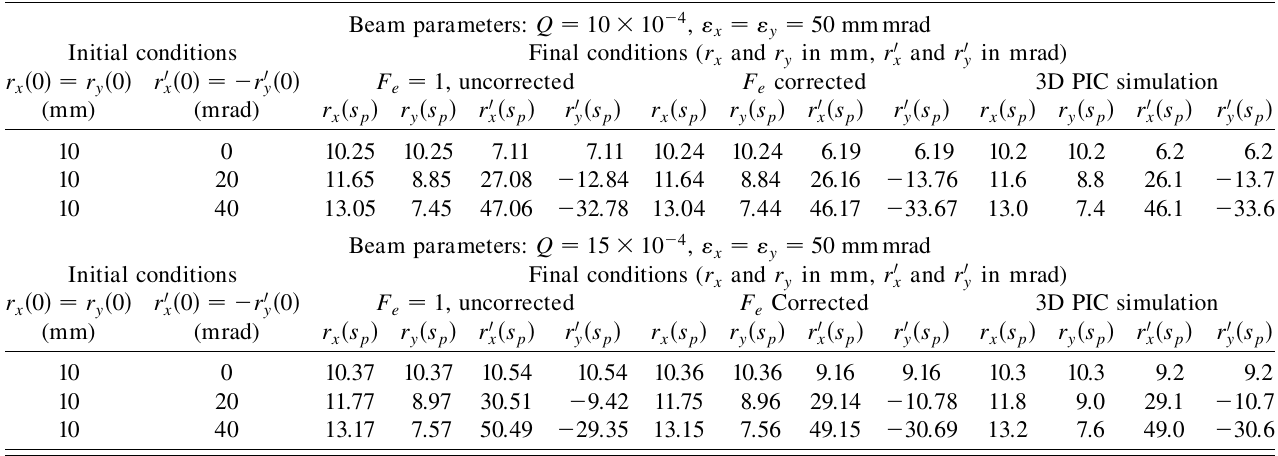
Initial and final envelope radii and angles for axisymmetric and elliptical beam initial conditions free drifting from (cid:1) 70 mm . Final envelope radii are shown for the following: uncorrected envelope with s (cid:1) 0 into a conducting plate at s (cid:1) s p (cid:1) 1 , linear corrected F F , and 3D self-consistent WARP PIC simulations. Upper and lower table entries have different values of e e perveance Q .